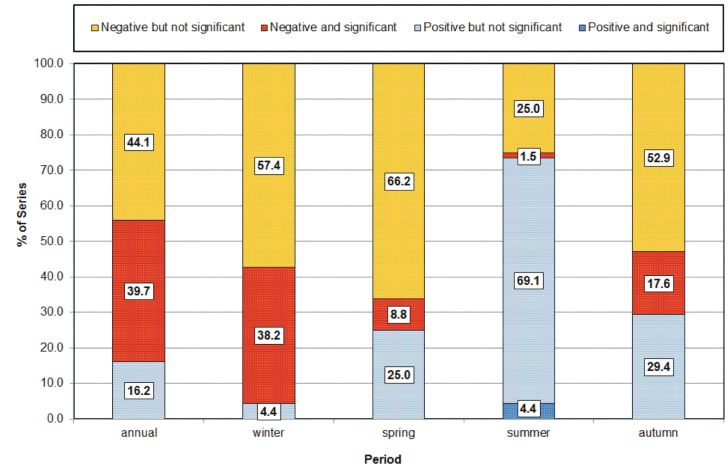
Fig. 4. Summary of the results obtained for the trends of the various time aggregations using MK test (total number of stations: 68). values concentrated in Basilicata, Calabria and Sicily.